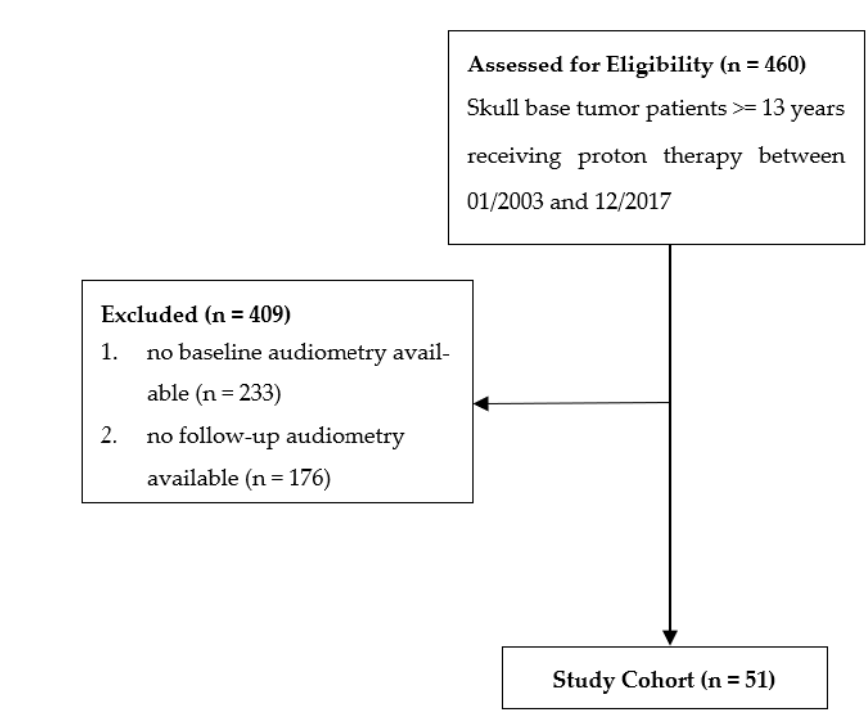
Figure 1. Flow diagram of patient inclusion.